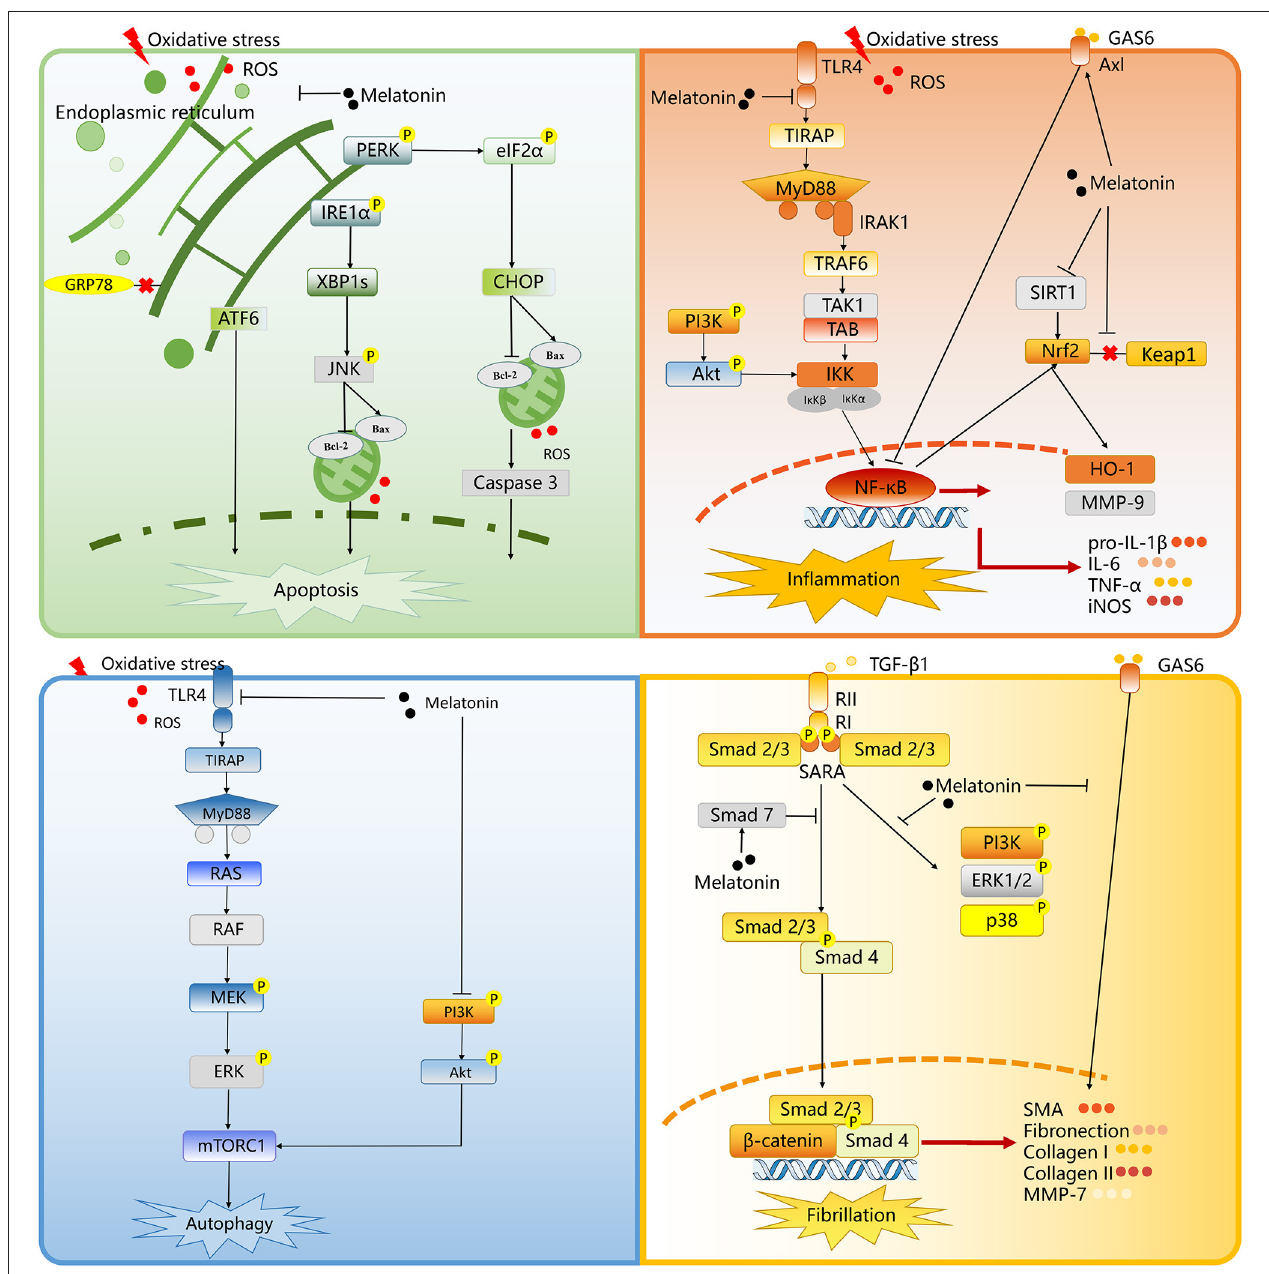
FIGURE 9 | The proposed molecular and cellular mechanism of the protective effect of melatonin for renal I/R injury. The figure was created based on the data of the studies. ROS, reactive oxygen species; PERK, protein kinase RNA-like endoplasmic reticulum kinase; eIF2a, eukaryotic translation initiation factor 2a; CHOP, C/EBP homologous protein; IRE1a, inositolrequiring enzyme 1a; XBP1s, X-box binding protein 1; ATF6, activating transcription factor 6; JNK, c-Jun NH2-terminal kinase; Bcl-2, B cell lymphoma-2; Bax, BCL-2 associated X; GRP78, glucose regulated protein 78; TLR4, Toll-like receptor 4; MyD88, myeloid differentiation 88; IRAK1, interleukin-1 receptor-associated kinases; TRAF6, tumor necrosis factor receptor-associated factor 6; TAK1, transforming growth factor beta-activated kinase1; IKK, IkappaB kinase; PI3K, phosphatidylinositol 3-kinase; NF- κ B, noncanonical nuclear factor-kappaB; HO-1, heme oxygenase 1; SIRT1, Sirtuin-1; MMP9, matrix metalloproteinase 9; GAS6, growth arrest-specific 6; Keap1, kelch-like ECH-associated protein 1; Nrf2, nuclear factor (erythroid-derived 2) factor 2; IL-6, interleukin 6; pro-IL-1ß, pro-interleukin-1beta; TNF-a, tumor necrosis factor-alpha; iNOS, inducible nitric oxide synthase; RAS, viral oncogene homolog; MEK, mitogen-activated protein kinase; ERK, extracellular regulated protein kinases; mTORC1, mammalian target of rapamycin complex 1; RII, transforming growth factor-ß receptor II; RI, transforming growth factor-ß receptor I; SARA, Smad anchor for receptor activation; TGF-ß1, transforming growth factor-ß; SMA, smooth muscle actin; MMP7, matrix metalloproteinase